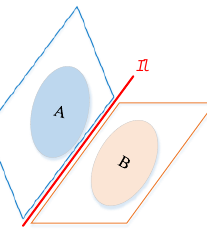
Figure 7. Illustration of an example of a topological relation between two planar regions ( A and B ) in 3D space. Table 2. Basic topological relations between primitives on the intersection line [56]. Type of Relations Graphical Representation Topological Relations Point-point relations Disjoint, Equal Line segment-point relations Disjoint, Meet, Contain Line segment-line segment relations